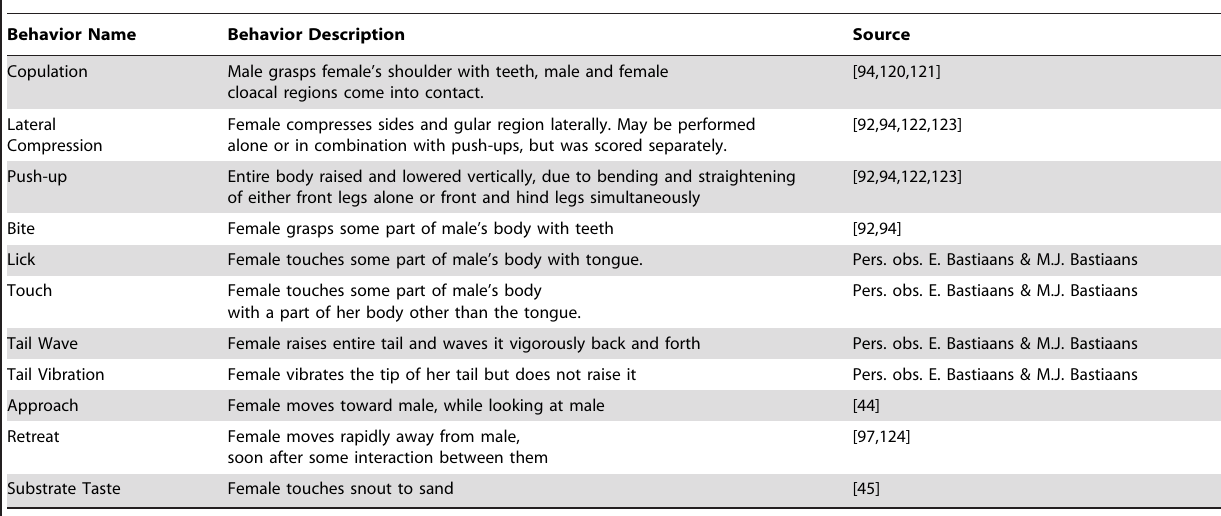
Table 1. Female behaviors scored a during mate choice trials.